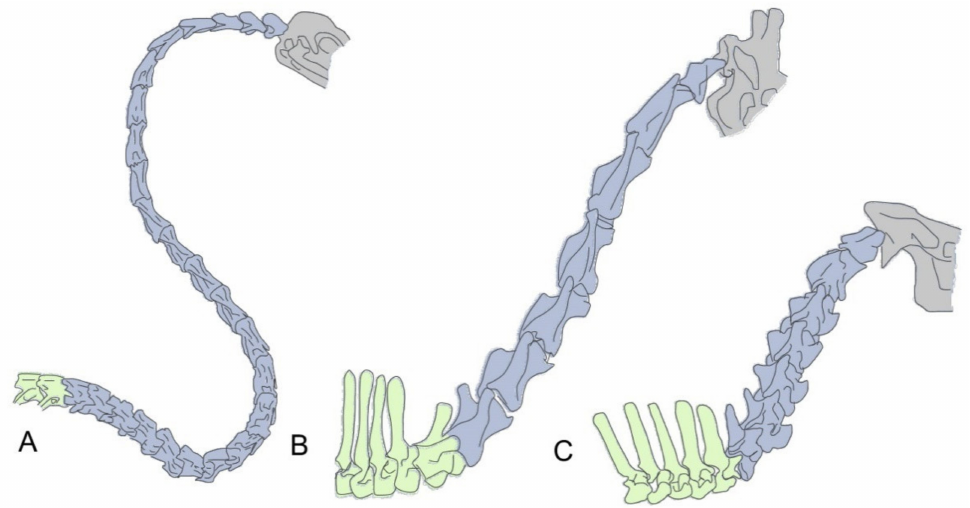
Figure 1. Two different mechanisms for neck size increase. ( A ) In birds, neck size is mostly related to the number of cervical vertebrae, illustrated here with the cervical region of a swan ( Cygnus olor ), which contains up to 25 cervical vertebrae. B,C Most mammals have seven cervical vertebrae and neck size differences depend on the size of their individual cervical vertebrae. Giraffes ( B ) (e.g., Giraffa camelopardalis ) are the paradigmatic example for a long necked mammal. Importantly, comparison with its closely phylogenetically related okapi ( Okapia johnstoni ) ( C ) shows that the change in vertebral size is restricted to the cervical region, as their thoracic vertebrae are of equivalent sizes (with the exception of the first thoracic of giraffes). Cervical vertebrae are colored in blue, thoracic vertebrae in green and the head in